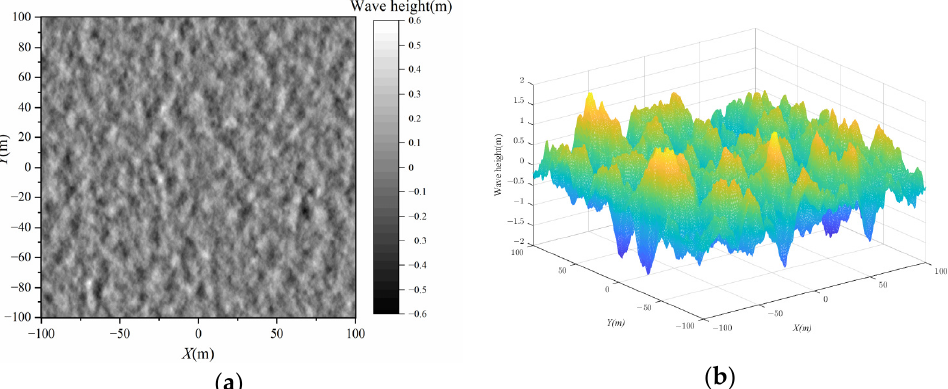
Figure 2. Sea surface simulation results based on Elfouhaily wave spectrum and Mitsuyasu directional function. ( a ) gray-scale image; ( b ) three-dimensional image.